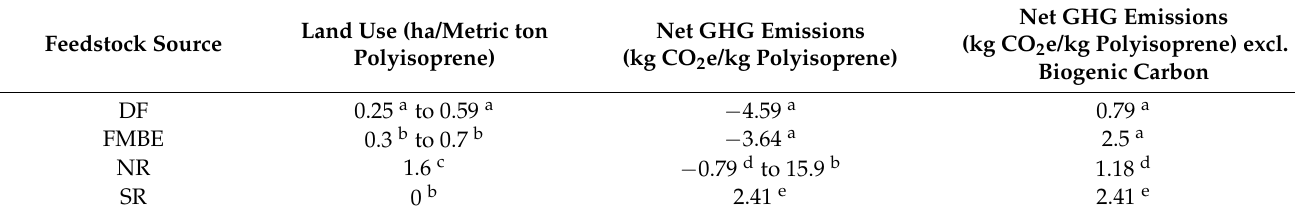
Table 5. Land Use Intensity and GW of Polyisoprene Produced from Different Feedstocks. Land Use (ha/Metric ton Feedstock Source Polyisoprene)